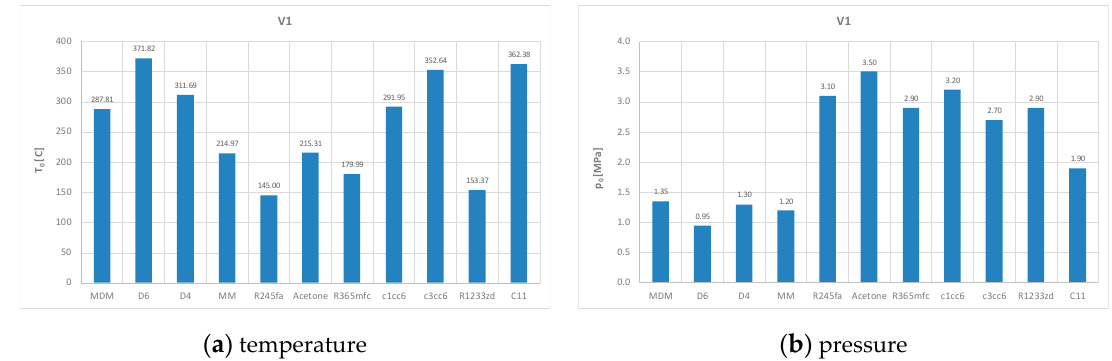
Figure 9. Values of temperature ( a ) and pressure ( b ) of live vapor optimized for different working media (Variant 1).